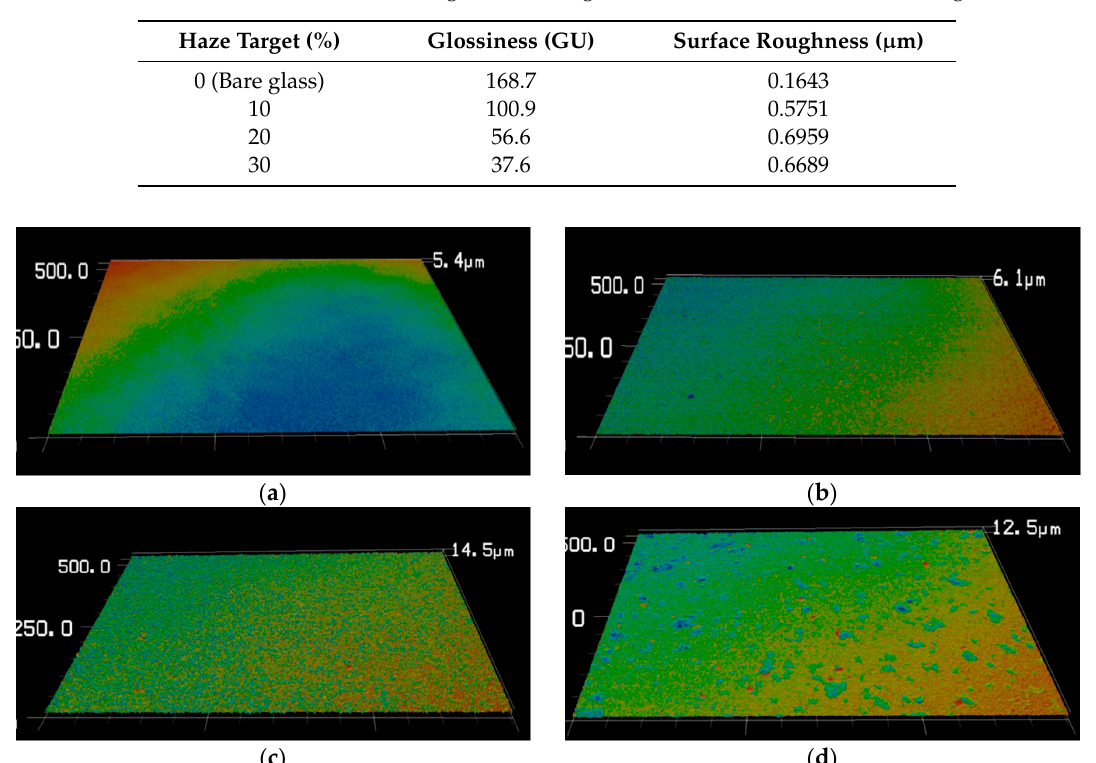
Figure 8. Comparison of surface treatment results according to the haze target value. Table 9. Glossiness and surface roughness of the glass substrates with various haze targets.